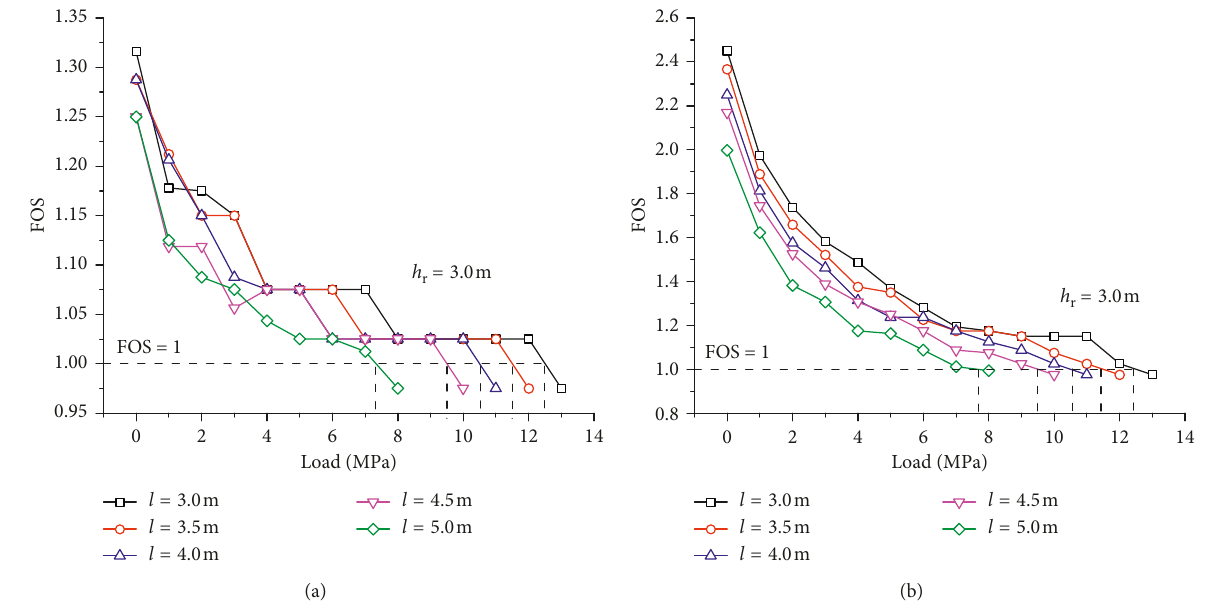
Figure 12: The relationship between load and FOS. (a) Scheme 1 and (b) scheme 2.